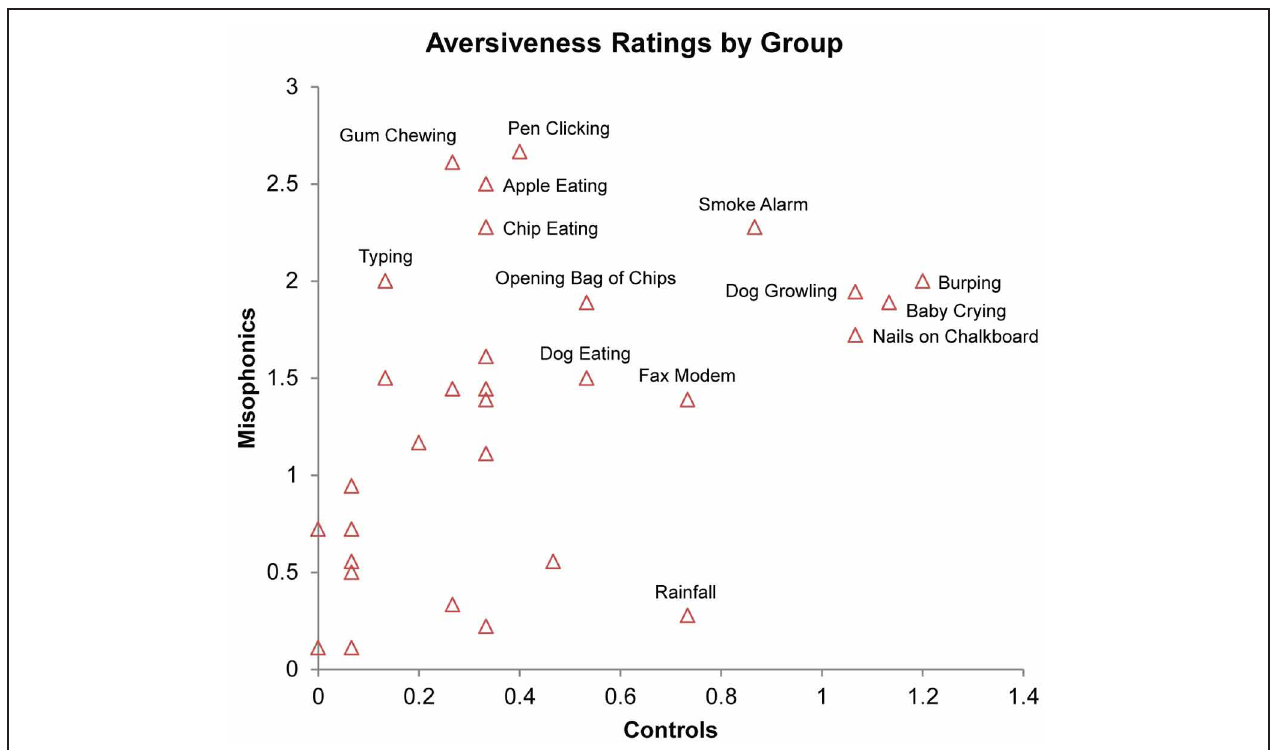
FIGURE 5 | Correlation of average aversiveness ratings of stimuli (x- and y-axis) across conditions in misophonics and controls. Select stimuli identified by proximal text.